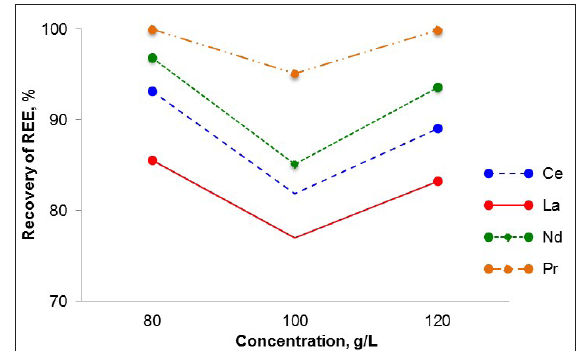
Fig. 4 Recovery of rare earth